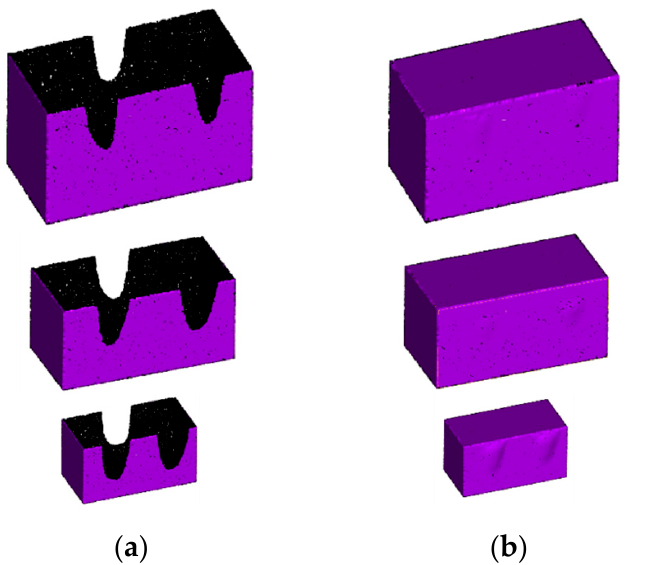
Figure 15. Repair results of cuboid point cloud models with different sizes: ( a ) before repair; ( b ) after repair. Table 2. The chamfer distance for cuboid point cloud models with different sizes before and after repair.